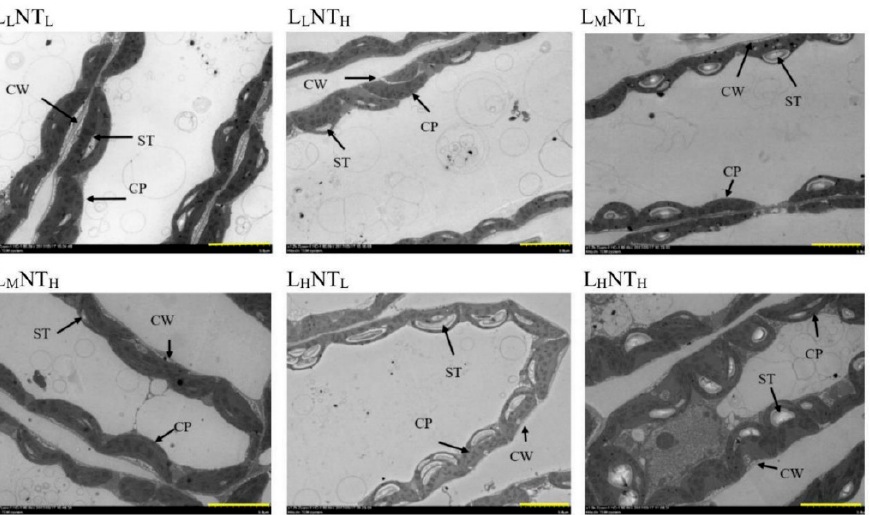
Figure 7. Electron microscopy of chloroplast in palisade tissue of cherry tomato grown under different light intensity (LI) and night temperature (NT). CP, chloroplast; CW, cell wall; ST, starch granule. Abbreviations of different treatments were as described in Figure 1. Scale bar is 5 μ m.